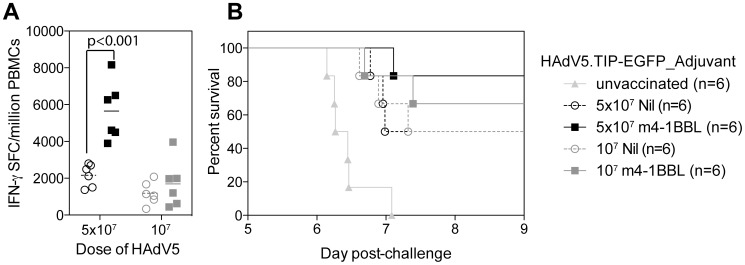
Challenge with P.berghei sporozoites.Balb/c mice (6 mice per group) were immunised i.m. with two different doses of HAdV5.TIP-EGFP or HAdV5.TIP-EGFP_m4-1BBL and challenged with 1000 P.berghei sporozoites 2 weeks later. The response to Pb9 in the blood was measured 2 days prior to challenge by IFN-γ ELISpot. A) The bar represent the median with each individual animal displayed as a single point. Data was analysed with a 2-way analysis of variance a post-hoc Bonferroni test; the p value denotes the level of statistical significance. B) Parasitaemia was measured daily and the time to 0.5% parasitaemia calculated by linear regression. Survival curves were compared with a log-rank (Mantel-Cox) test but no significant difference between groups was observed.